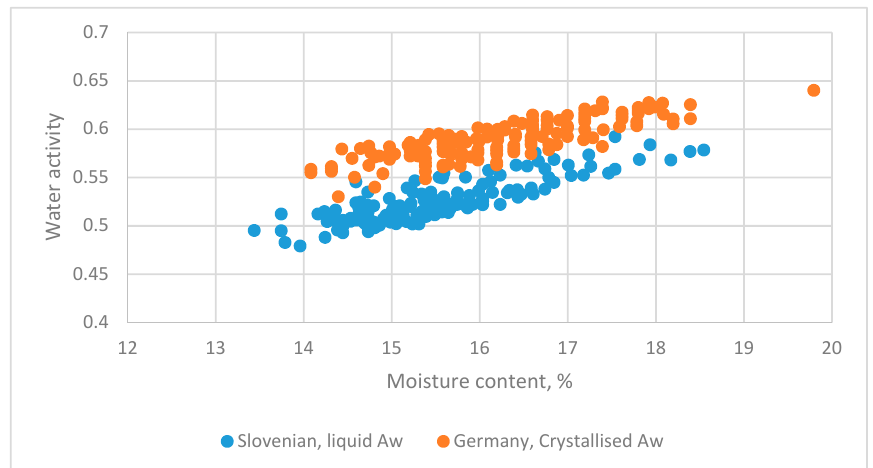
Figure 12. The relationship between water activity and moisture content for datasets for honey from Germany [8] and Slovenia [5].